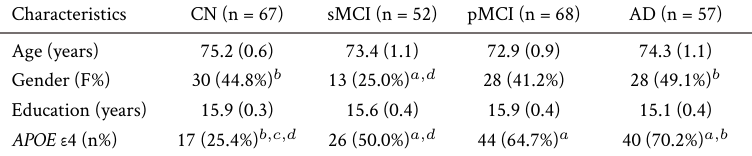
Table 1. Demographics of subjects at baseline.